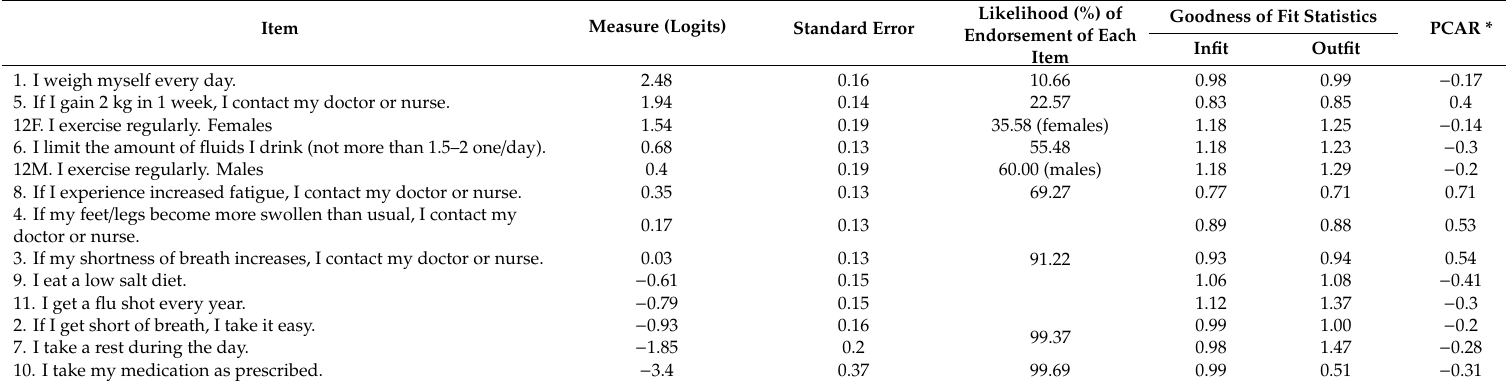
Table 3. Results of the Rasch model